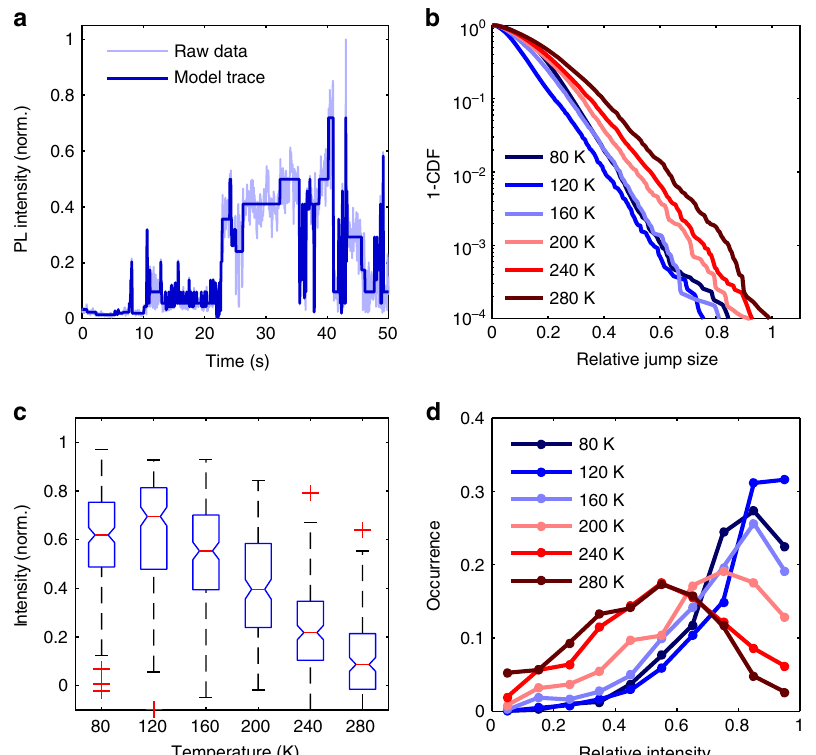
Fig. 3 Analysis of the relative PL intensity fl uctuations. To make the blinking amplitudes comparable, we divided each model trace by its maximum and extracted relative blinking amplitudes ranging between 0 and 1. Panel a shows an intensity transient recorded at 240 K and the corresponding model trace, from which jump events were extracted. One minus the cumulative distribution function (1 — CDF) of the relative blinking amplitudes is presented in b . The function 1 — CDF(x 0 ) gives the probability for x to be larger than x 0 . For example, at 280 K the probability for the relative jump size to be more than 0.4 is 0.2. The box plot in c shows the distributions of the lowest relative intensity values. The central marks indicate the median of the distribution and the upper and lower limits of the boxes correspond to the 25th and the 75th percentiles of the respective intensity distributions. The length of the whiskers corresponds to the intensity value, which is closest to the 1.5-fold box size. Data points exceeding this range are considered as outliers (red crosses). Panel d shows the occupation probability of intensity levels calculated from the intensity normalized model